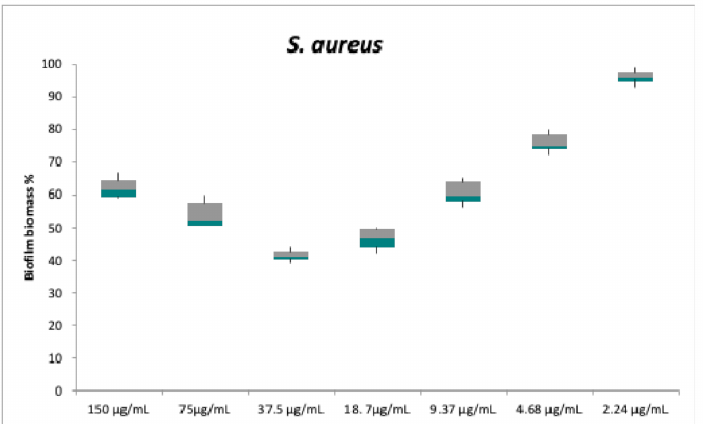
Figure 4. In vitro biofilm formation of S. aureus following an overnight treatment with serial dilutions of compound 3 . Biofilm formation was determined by the cristal violet assay. Biofilm biomass values are presented as the mean percentage ± standard deviation (SD) and S. aureus biofilm biomass without a treatment is assumed to be 100%. Each pair of means was compared using a Tukey’s multiple comparisons test; no significant differences were detected between the following pairs: 150–9.37 µ g/mL; 37.5–18.7 µ g/mL.